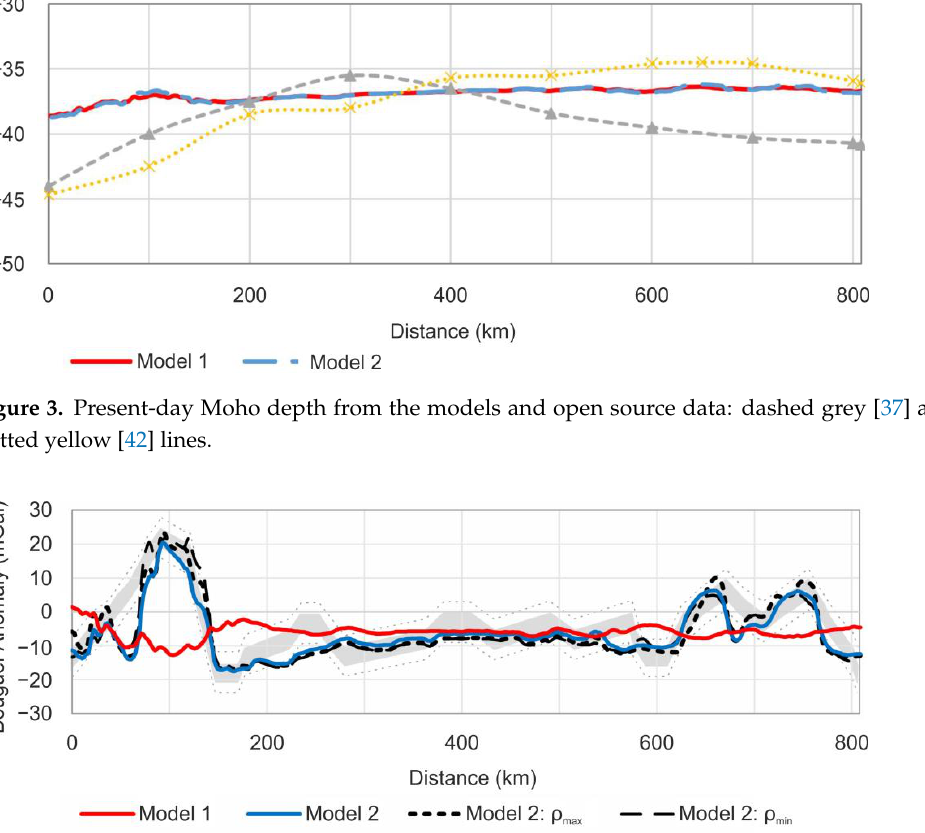
Figure 4. Comparison of Bouguer anomaly observed data digitised from the gravity map [68] (grey stripe) and calculated data for Model 1 (solid red line), Model 2 (solid blue line) and two models of the sensitivity study, Model 2: ρ max (dashed black line) and Model 2: ρ min (solid black line). Dotted grey lines show the ±1.5 mGal interval relative to the observed values.